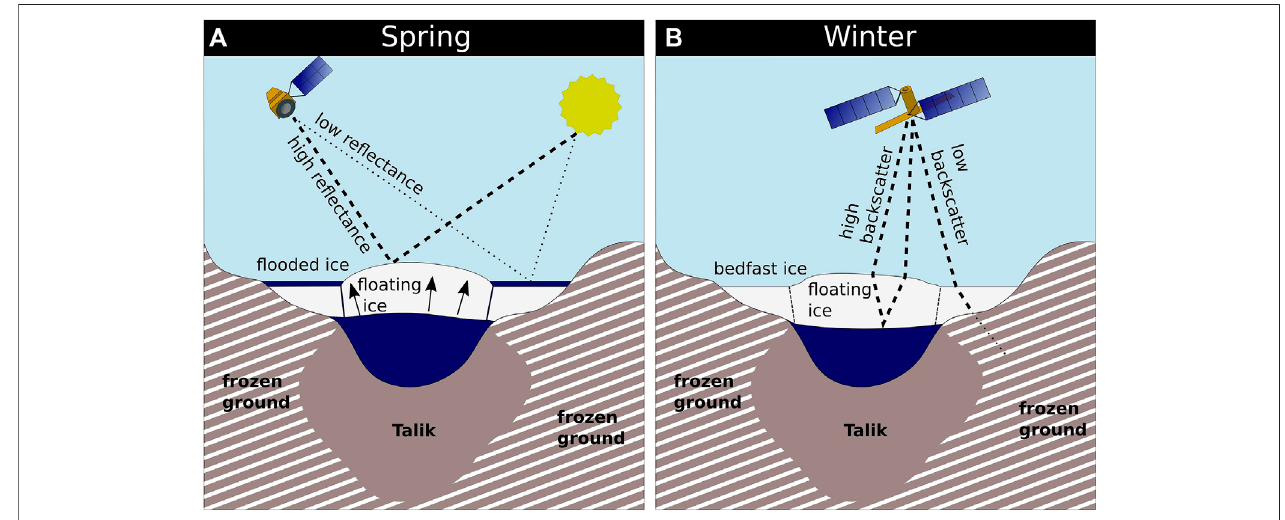
FIGURE7| The sharpcontrastinalbedobetweenexposedserpentineice and fl ooded bedfast iceisvisible inoptical imageryduring the spring fl ood (A) .In winter, the ice-water interface below serpentine ice is an effective re fl ector and produces a high radar backscatter signal (B) .